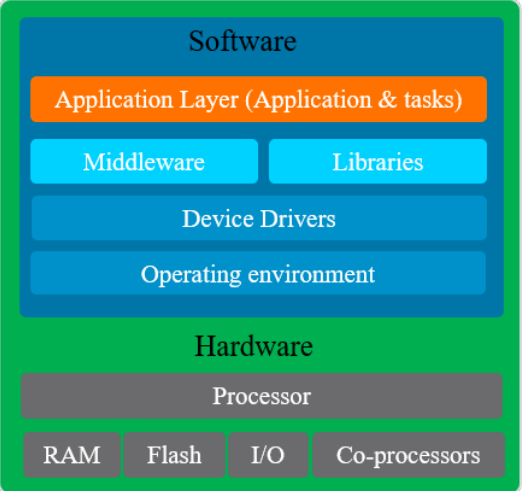
Figure 6. Layers of the EBCI based on hardware/software